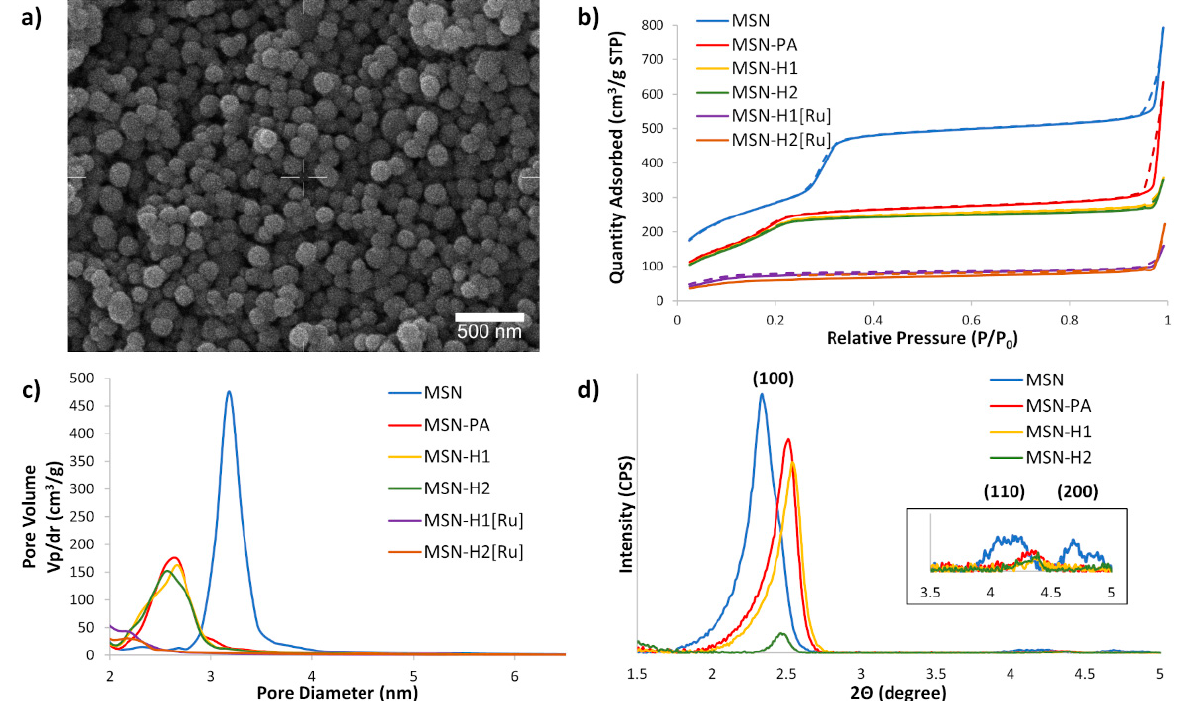
Figure 2. ( a ) SEM micrograph of MSN; ( b ) BET N 2 adsorption/desorption isotherms of the synthesized materials, with solid and dashed lines referring to the adsorption and desorption processes, respectively; ( c ) BJH average pore diameter distribution for synthesized materials and ( d ) SAXS patterns of prepared nanoparticles. Inset shows higher magnification of (110) and (200) reflections of MSN. Table 1. BET surface area, mesopore volume values, average and BJH pore diameter.